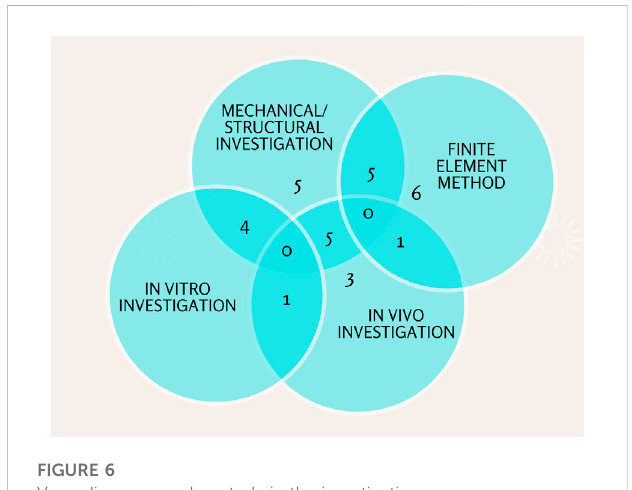
FIGURE 6 Venn diagram number study in the investigation process.